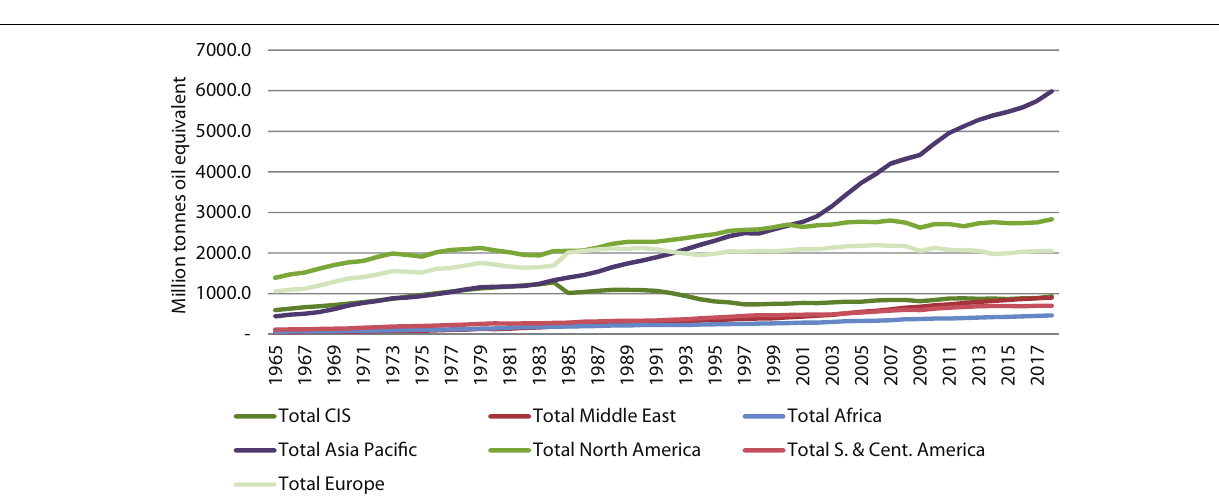
reviewed urban energy transition in the Netherlands with